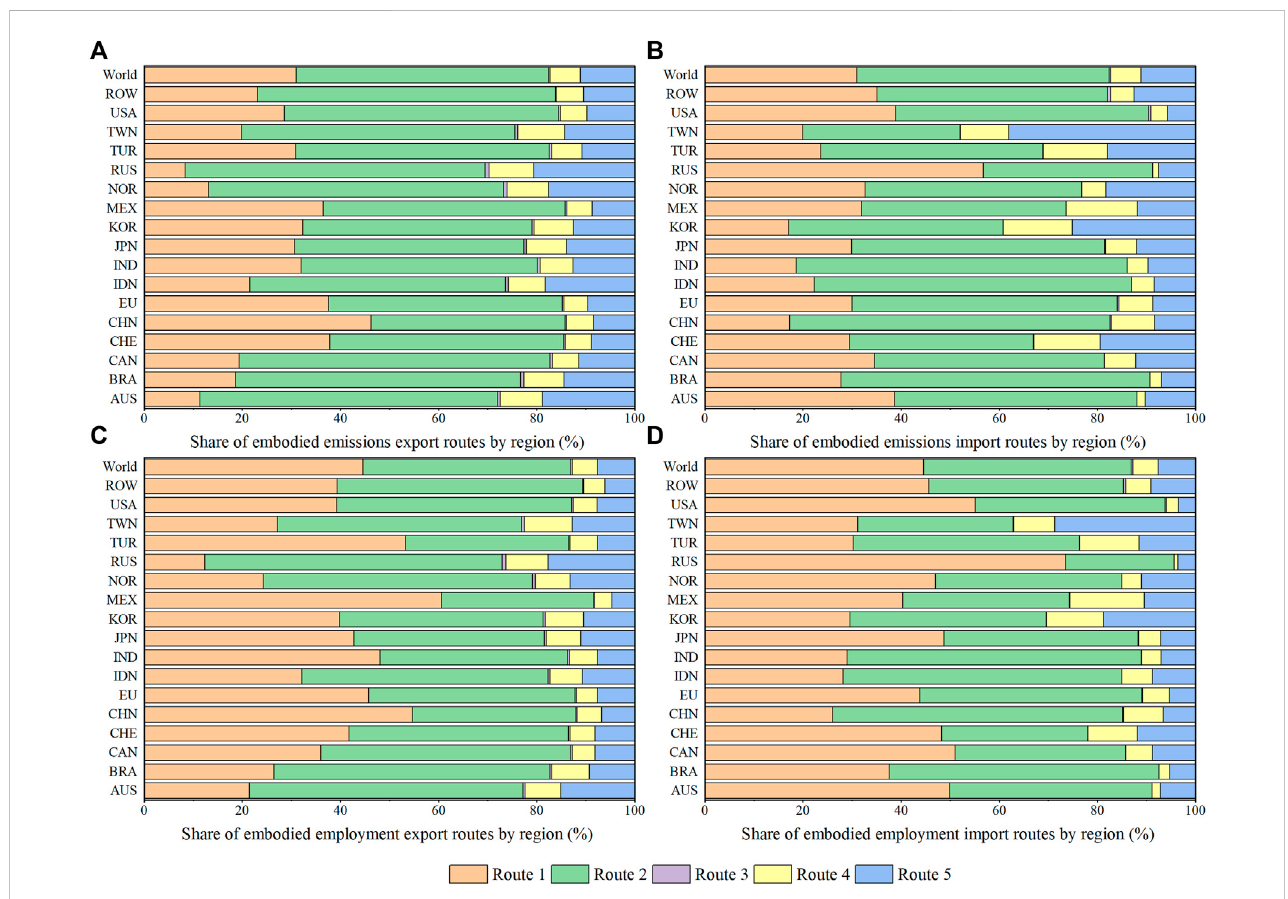
FIGURE 3 Regionalcomparisonsoftheembodied carbonemissions export (A) andimport (B) routes,and embodiedemploymentexport (C) andimport (D)